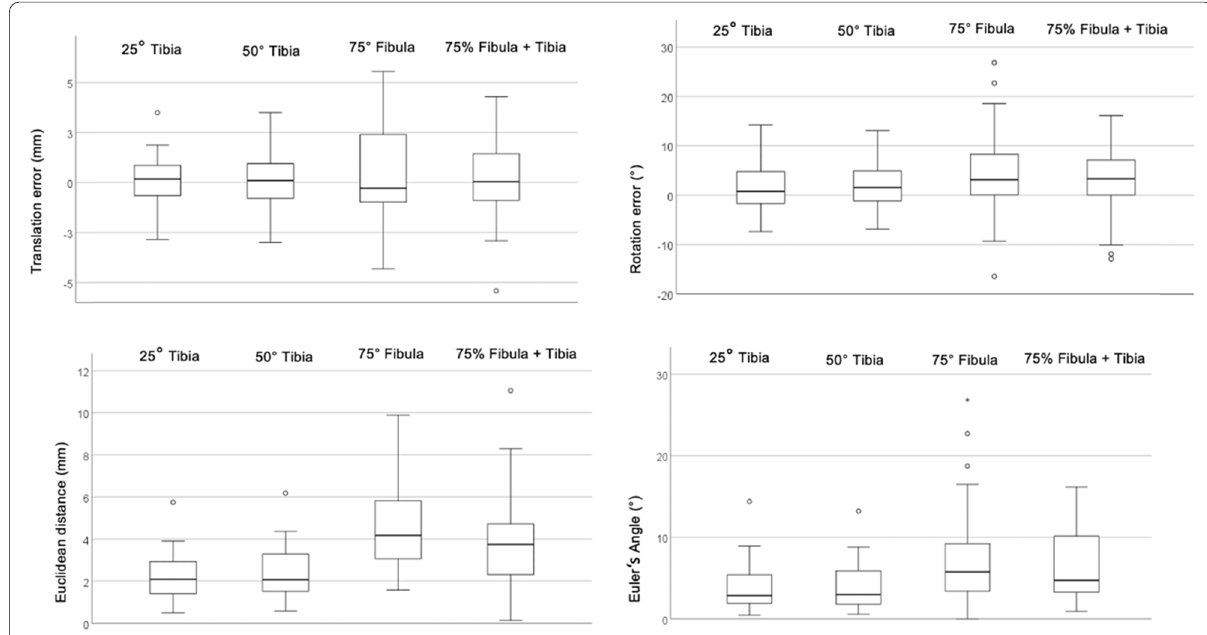
Fig. 4 Median errors for all segments. Y‑axis depicts median translation error, median rotation error, median Euler’s angle and median Euclidean distance for all four segments; IQR (box), range (whiskers) and outliers